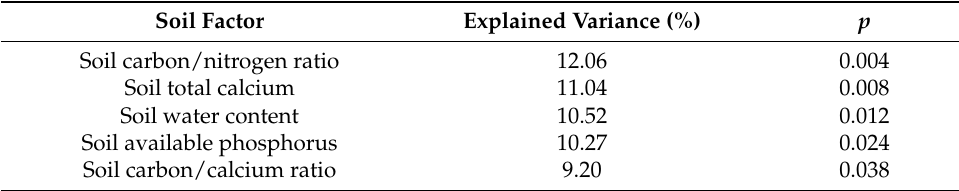
Table 5. Soil factor explained variance and significance